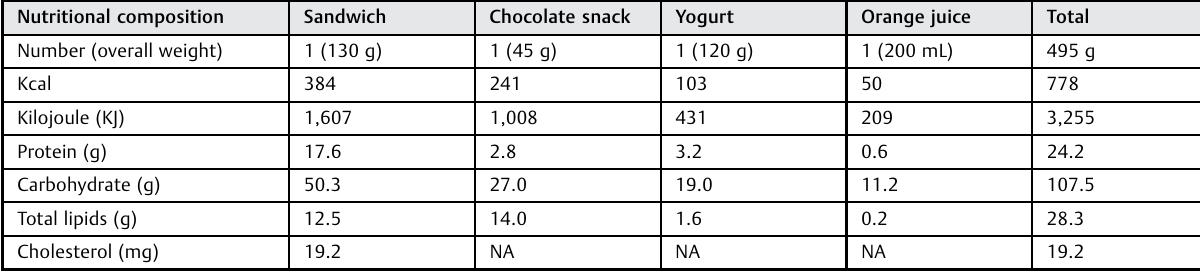
Table 1 Nutritional composition of Chilean breakfast Nutritional